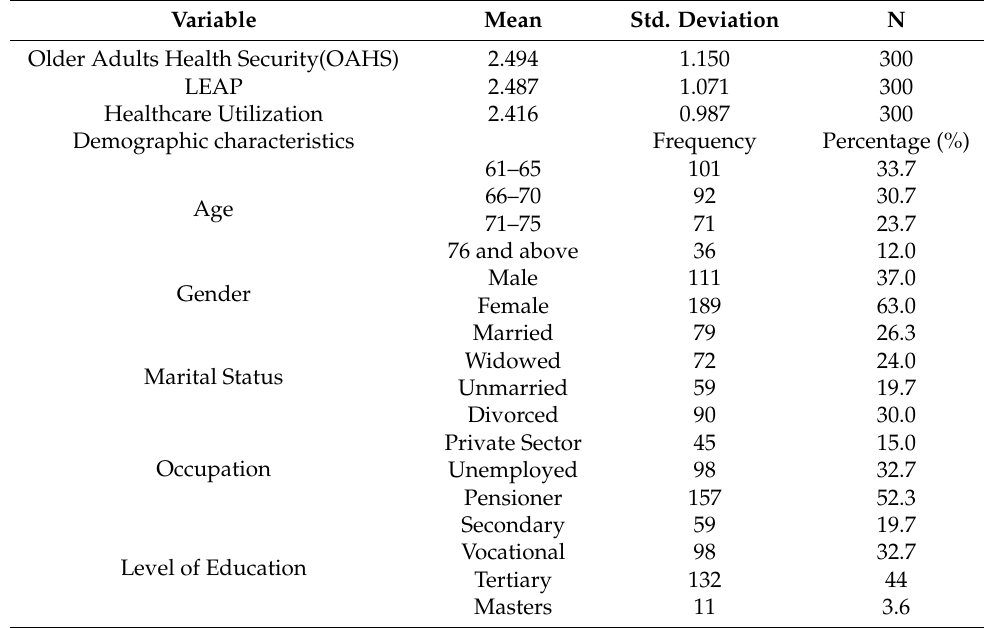
Table 1. Descriptive Statistics of variables.